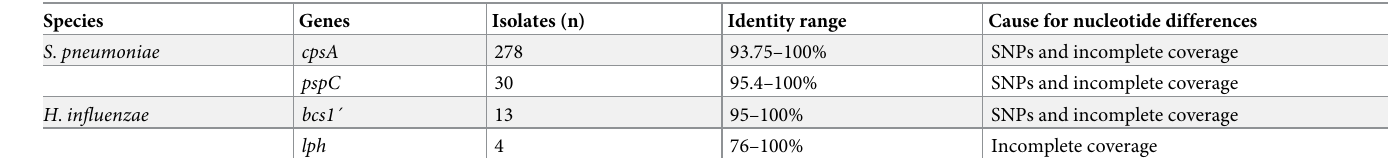
Table 1. 5 0 -UTR sequences of cpsA , pspC , bcs1´ , lph were analysed using nBLAST for occurrences in other isolates. Number of isolates identified (n).